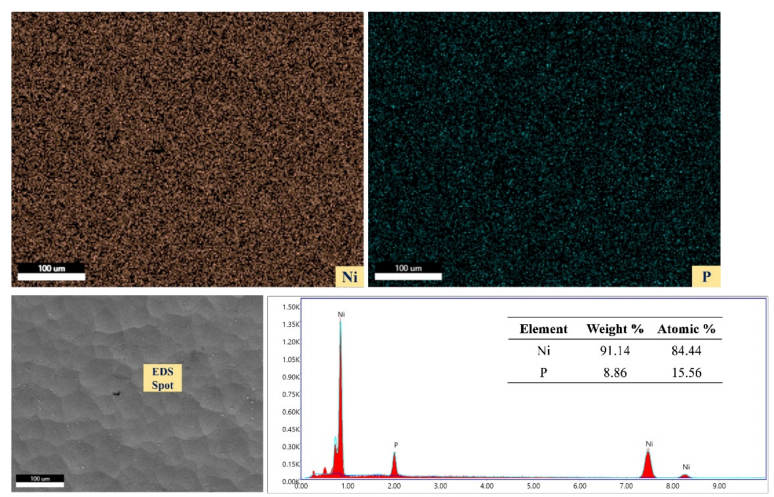
Figure 5. Elemental area mapping and spot analysis of as-plated surface. The topography of the as-plated surface is shown in Figure 6. The average areal surface roughness (Sa) of the surface was found to be 960 nm. The surface is rough and has an uneven distribution of peaks and valleys. The surface roughness of the plated surface is directly related to the constituents of the nickel bath during the electroless plating process.